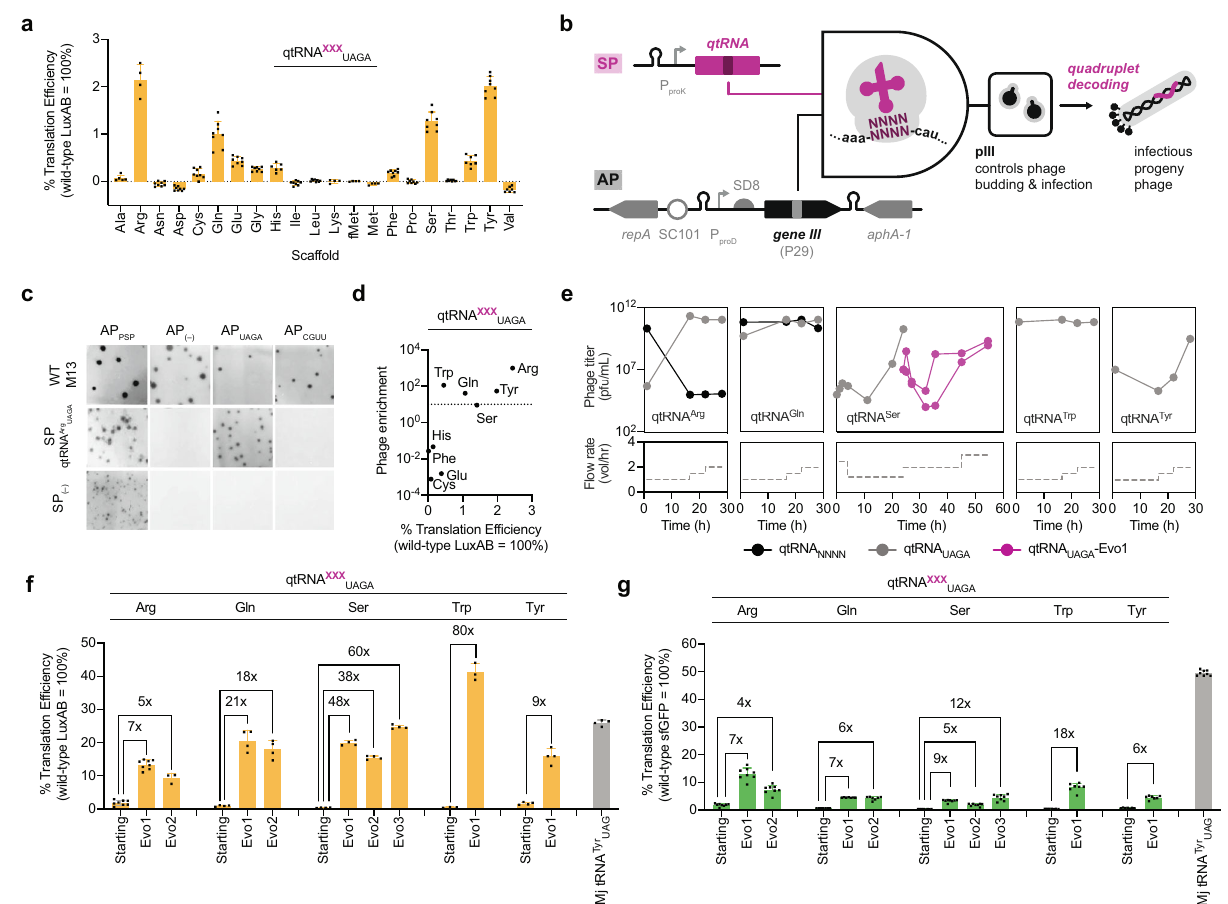
Fig. 2 Continuous directed evolution of qtRNAs improves quadruplet codon decoding. a Engineered UAGA-qtRNAs using representative scaffolds for each of the 20 elongator tRNAs and initiator (fMet) tRNA validated using the LuxAB reporter assay with UAGA incorporated at residue S357; qtRNA fMet UAGA uses a reporter with UAGA at residue 1 of LuxAB. In all data, qtRNA XXX UAGA contains a 5 ′ -UCUA-3 ′ anticodon that should decode the cognate UAGA quadruplet codon in an mRNA and “ XXX ” refers to the corresponding amino acid charged onto the tRNA scaffold. ( n = 8 biologically independent samples except for Trp/Val n = 7; His n = 6; Ala n = 5; Arg/Lys/fMet/Met n = 4.) b Schematic representation of qtRNA-PACE circuit. Selection phages (SPs) encoding a functional qtRNA enables the translation of a quadruplet codon in gIII (encoded on an accessory plasmid; AP), resulting in the production of full-length pIII and infectious progeny phage. c SP-borne qtRNAs enable propagation as visualized by plaque assay. Mismatched qtRNA/AP pairs fail to generate phage and do not result in plaque formation. SP( – ) indicates an SP lacking a qtRNA, and AP( – ) indicates cells without an AP. d UAGA qtRNAs with detectable activities using the LuxAB reporter were tested in SP propagation assays, showing that η ≥ 0.5% are necessary to support phage enrichment above input (visualized as a dotted line). e Quanti fi cation of SP titers and fl ow rates during qtRNA-PACE campaigns using AP 1xUAGA . Experiments were initiated with either a clonal (gray) or degenerate (black) qtRNA population, or the evolved variant Ser UAGA -Evo1 (purple). The second leg of qtRNA-PACE with qtRNA Ser UAGA uses the more stringent AP 3xUAGA . MP6 was used in all qtRNA-PACE experiments. qtRNA activities prior to (starting) and following (Evo) qtRNA-PACE campaigns and their associated fold improvements as quanti fi ed using LuxAB ( f ) or sfGFP ( g ) reporters. For LuxAB data, n = 4 biologically independent samples except for Arg-UAGA, and UAGA-Evo1 n = 8; Arg-UAGA-Evo2 n = 3; and Trp n = 3. For sfGFP data, n = 8 biologically independent samples except for Gln,Trp, and Tyr n = 7. Comprehensive sfGFP peptide fragmentation spectra for all engineered and evolved UAGA-decoding qtRNAs are reported in Supplementary Fig. 7. In all cases, reporter data is normalized to an otherwise wild-type protein and color- coded by the used reporter. Data represent the mean and standard deviation as